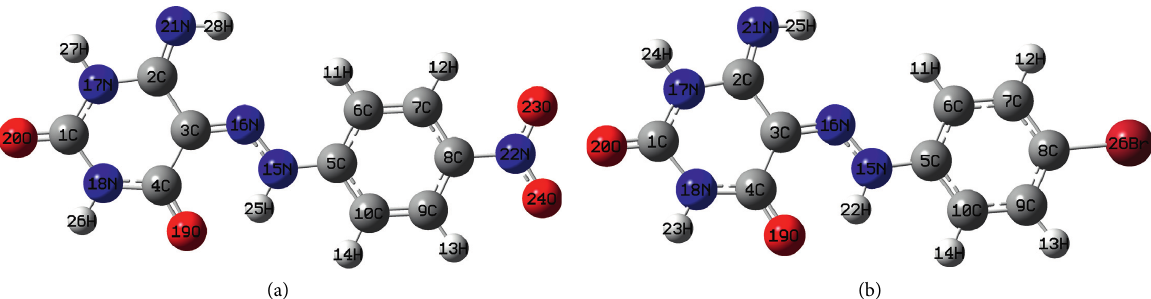
Figure 1: The molecular structures in the imine-diketo-hydrazone form of (a) dye I and (b) dye